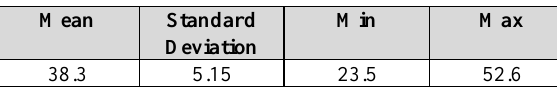
Figure 1 . Cotton Plantation Area